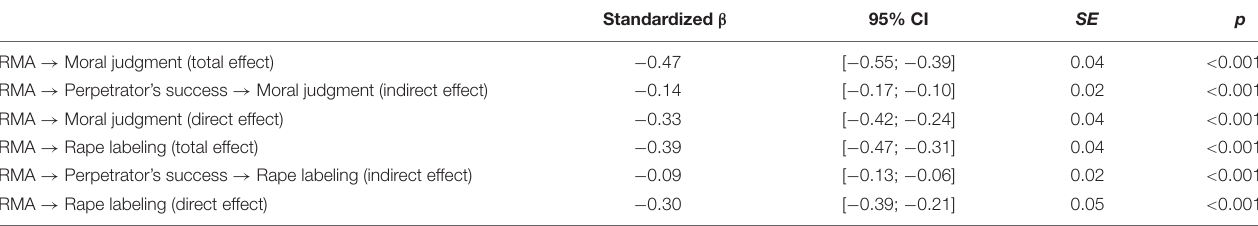
TABLE 3 | Standardized estimates of direct and indirect effects on moral judgment and rape labeling in Study 1.